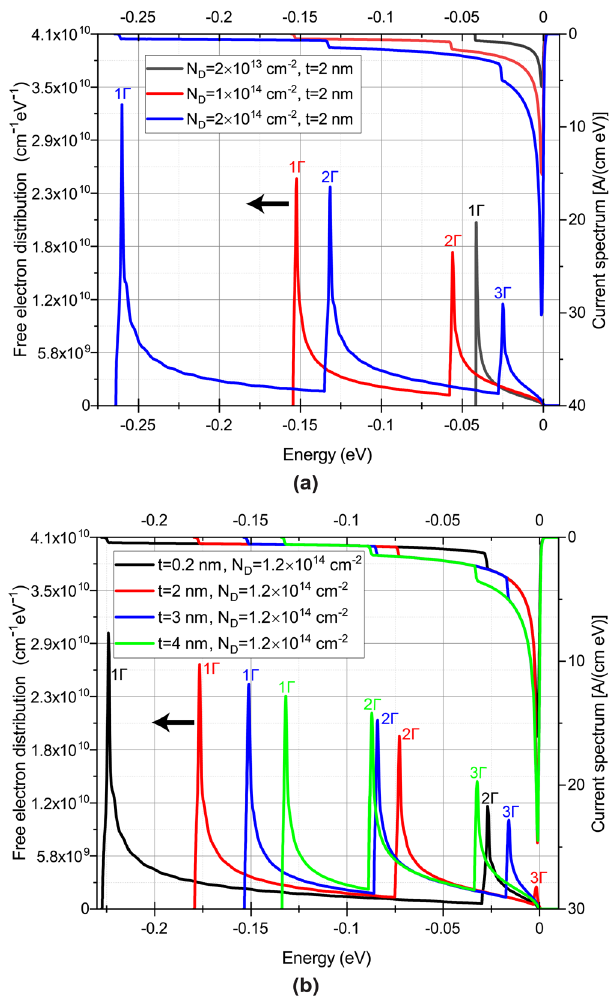
Fig. 3 Free electron energy distribution and current spectrum. In fl uence of the δ -layer thickness, t , and the donor doping density in the δ -layer, N D , on the free electron energy distribution per unit length along the y -axis (i.e., the DOS per unit length weighted with the Fermi – Dirac distribution) and current spectrum for an applied low voltage (1 mV): a for a fi xed δ -layer thickness of t = 2 nm, and b for a fi xed sheet doping density of N = 1.2 × 10 14 cm − 2 . D